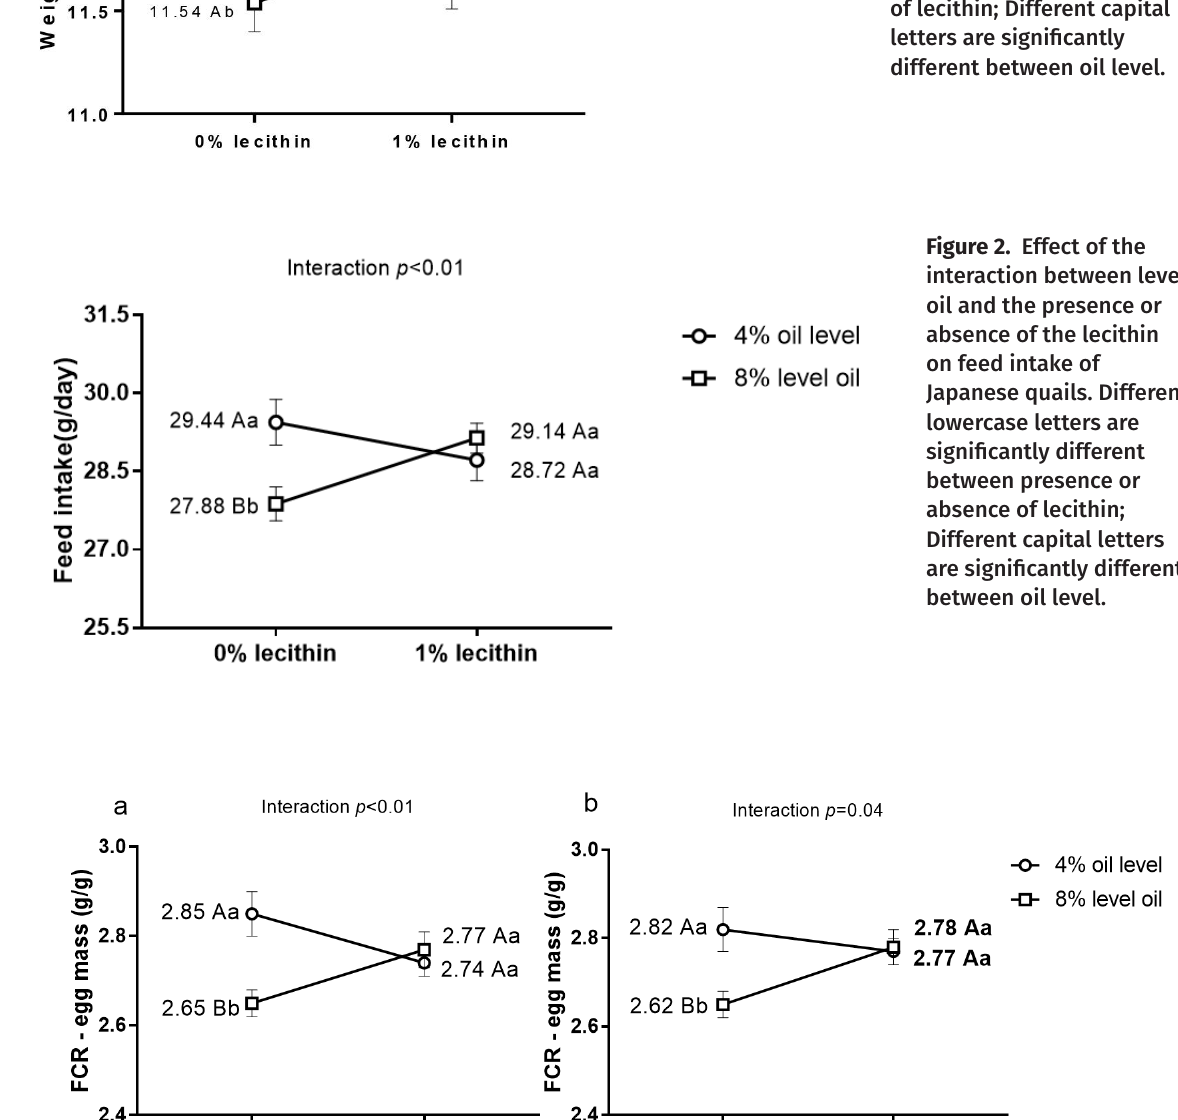
Figure 1. Effect of the interaction between level oil and presence or absence of lecithin on weight eggs of